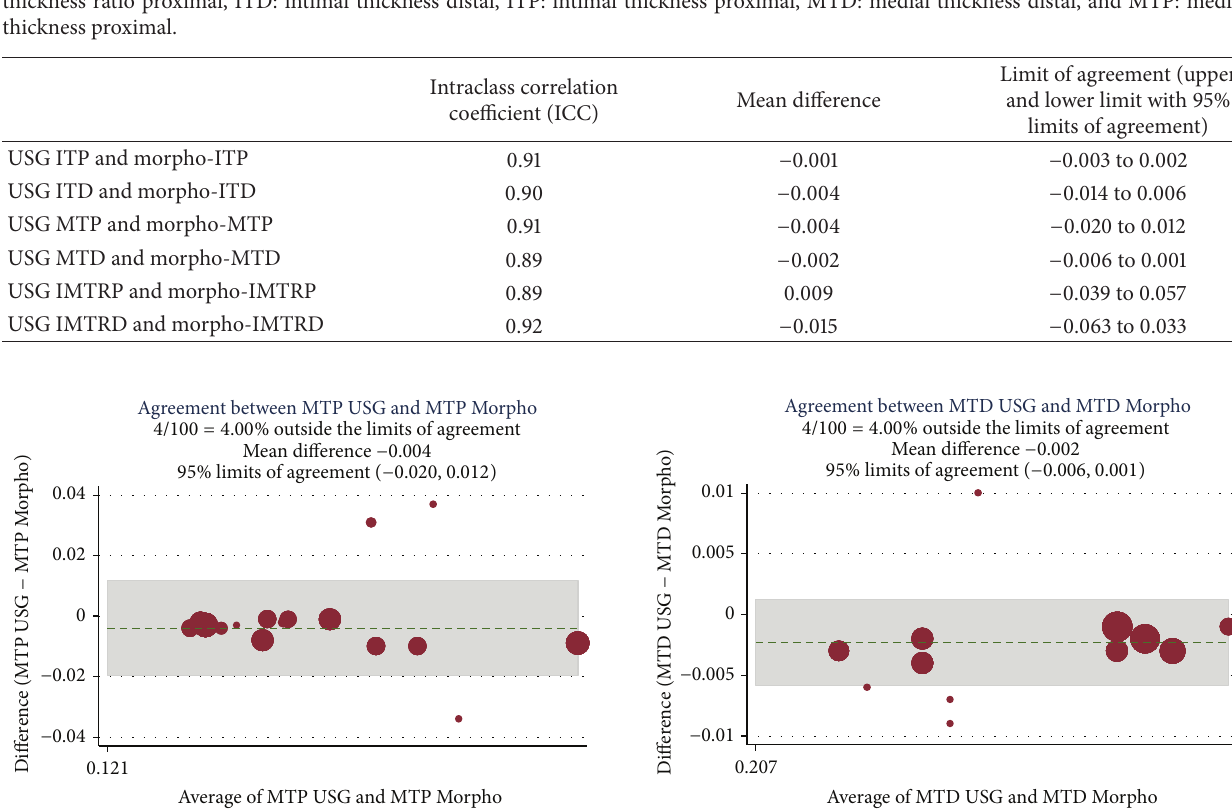
Figure 3: ICC was 0.91 with mean difference of − 0.004; limit of agreement was 95% with upper and lower limit of − 0.020 and 0.012. 4% values are above the limit of agreement, which means both of the methods are in agreement.